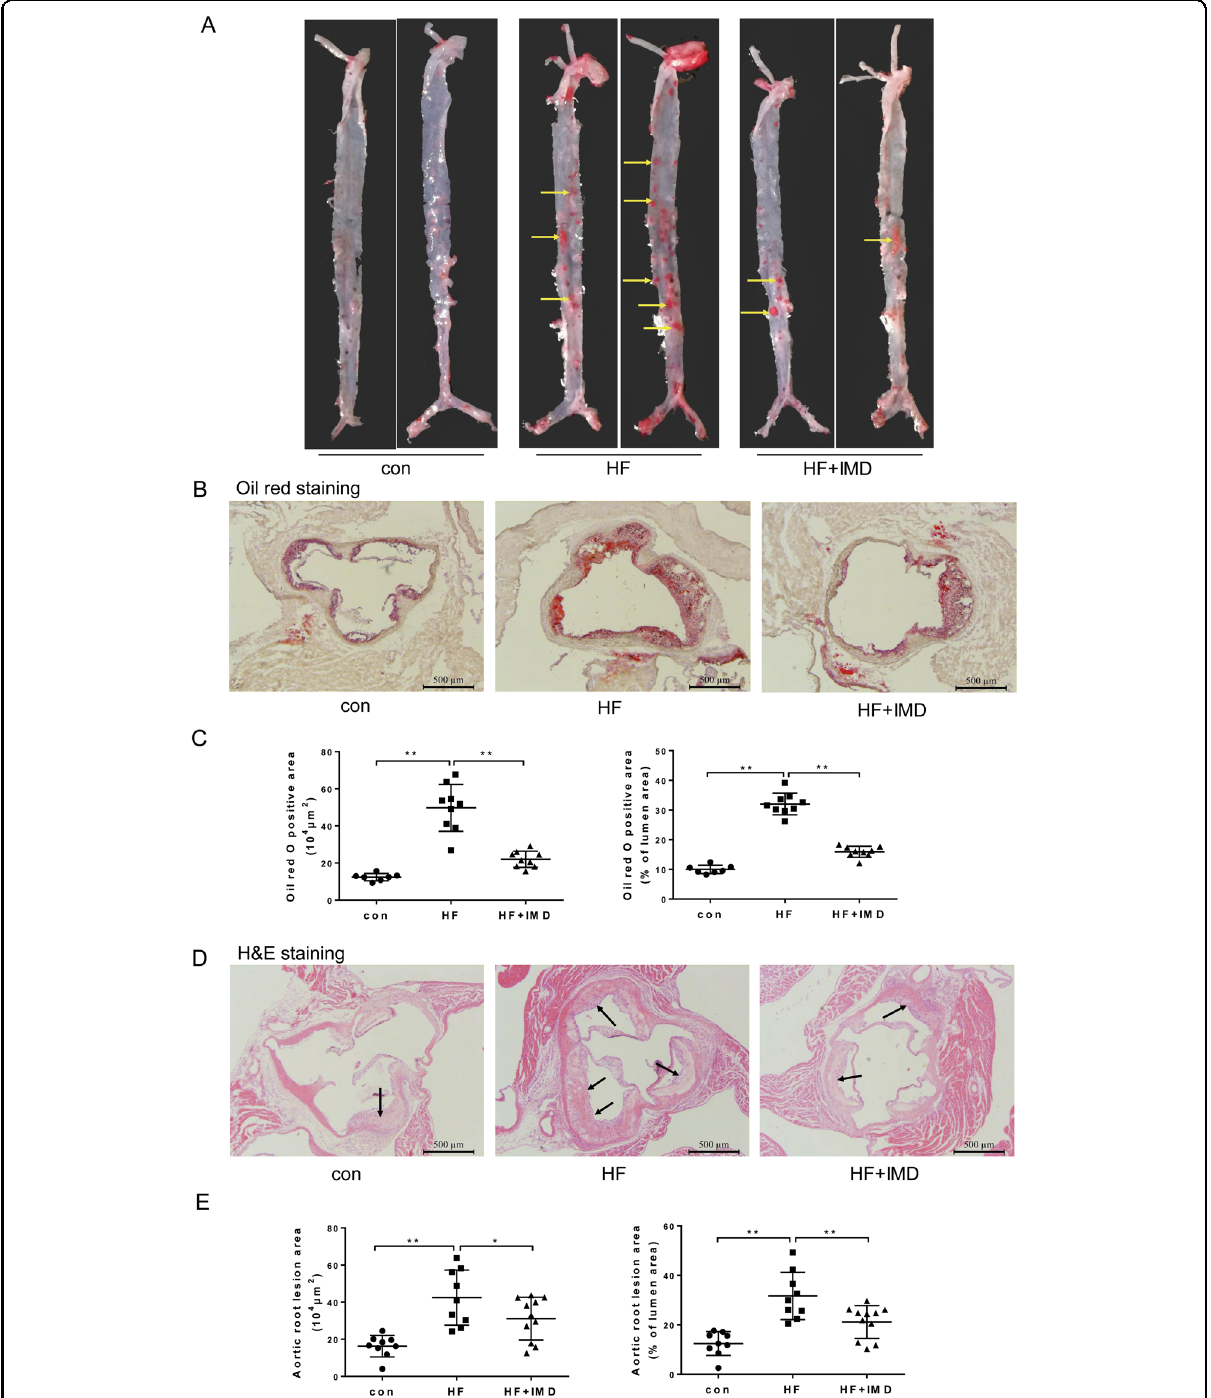
Fig. 1 IMD 1-53 alleviated atherosclerotic lesions at the aortic root of ApoE − / − mice. Eight-week-old male ApoE − / − were fed a standard chow diet (con) or a high-fat diet (HFD) for 16 weeks. After 10 weeks of HFD feeding, ApoE – / – mice received either PBS or intermedin 1-53 (IMD 1-53 ) during the left 6 weeks of high-fat diet feeding. A Gross view of en face-prepared aortas stained with Oil Red O. The red dots are lesions stained positively for Oil Red O. Yellow arrows pointed to the Oil red O-stained lesions. B Representative image of Oil red O-stained aortic root lesions. Scale bars, 500 μ m. C Quanti fi cation of Oil red O positive area. D Representative image of H&E-stained aortic root lesion. Black arrows indicate the atherosclerotic lesions. Scale bars, 500 μ m. E Quanti fi cation of aortic root lesion area. n = 7 – 11. Data are mean ± SD. * P < 0.05, ** P < 0.01; one-way